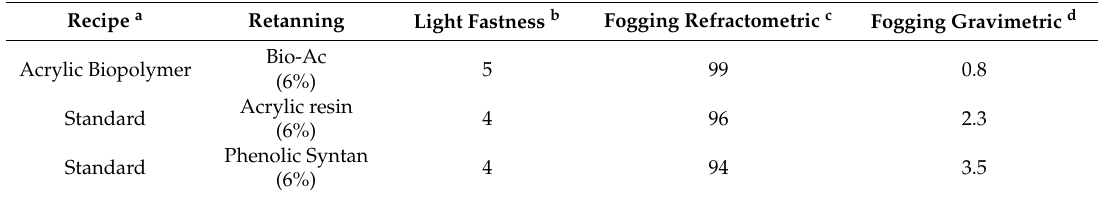
Table 4. Physical Tests for Crust Leather.